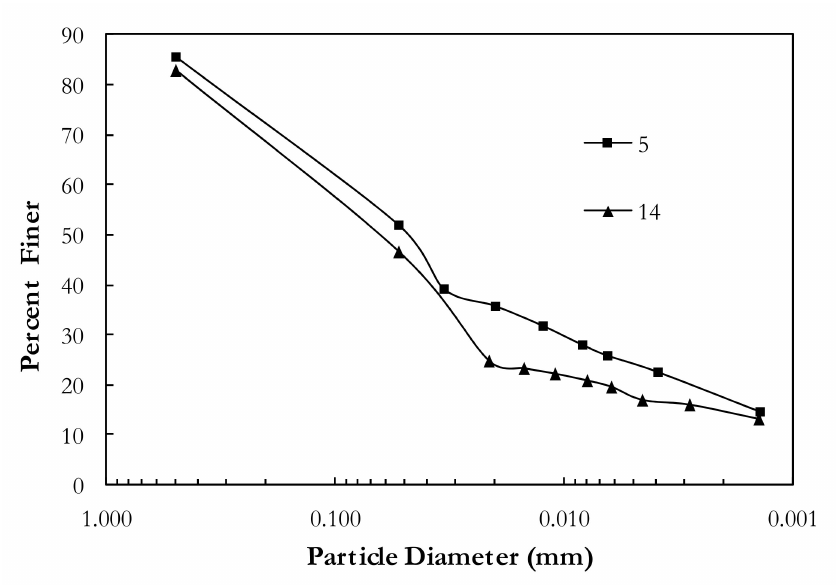
Figure 5. Particle size distribution of ARRI soils. Results from the Bent Mountain Mine (5 y) and Starfire Mine (14 y) sites.